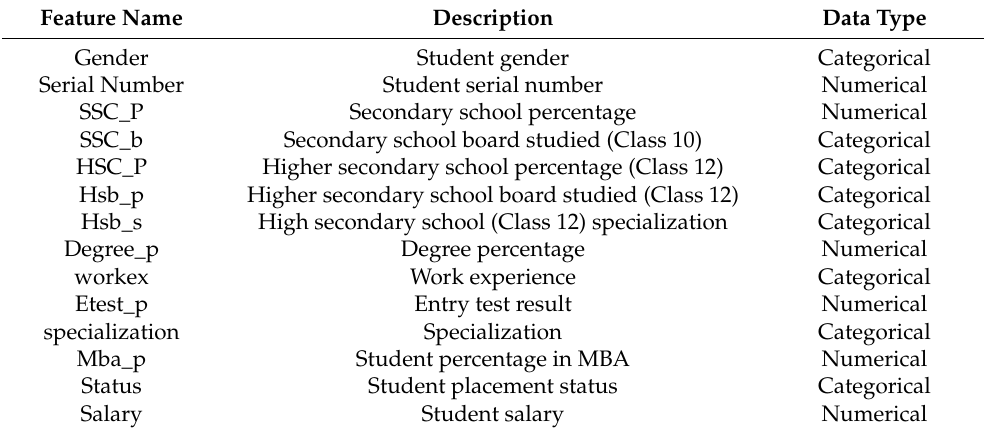
Table 1. Dataset Table 1. Dataset description.